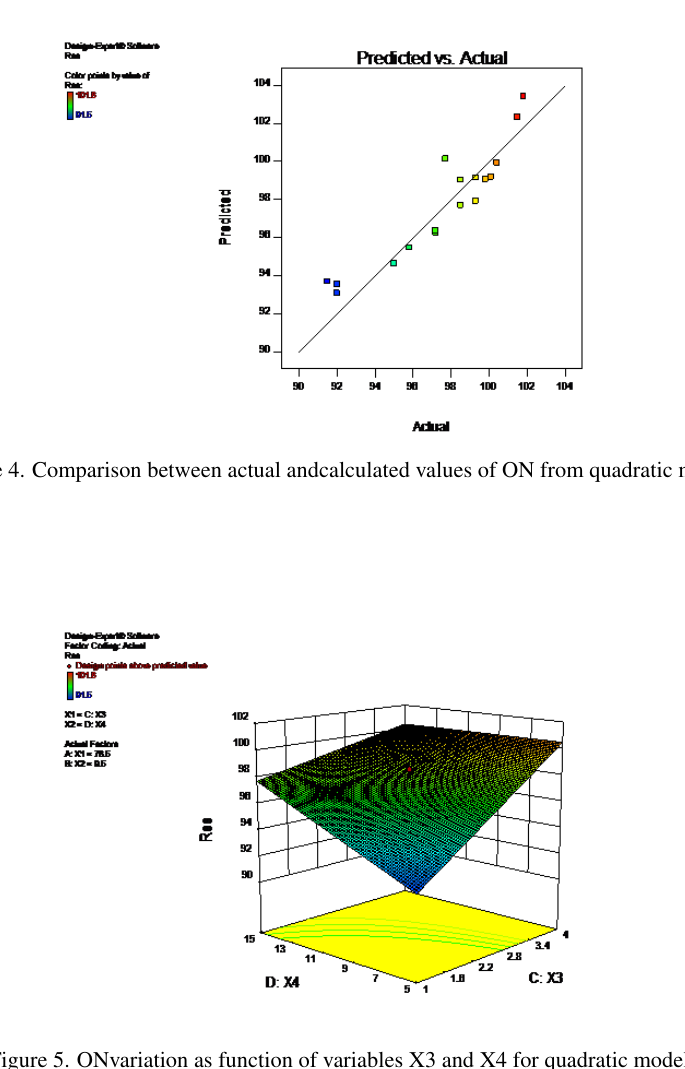
Figure 5. ONvariation as function of variables X3 and X4 for quadratic model